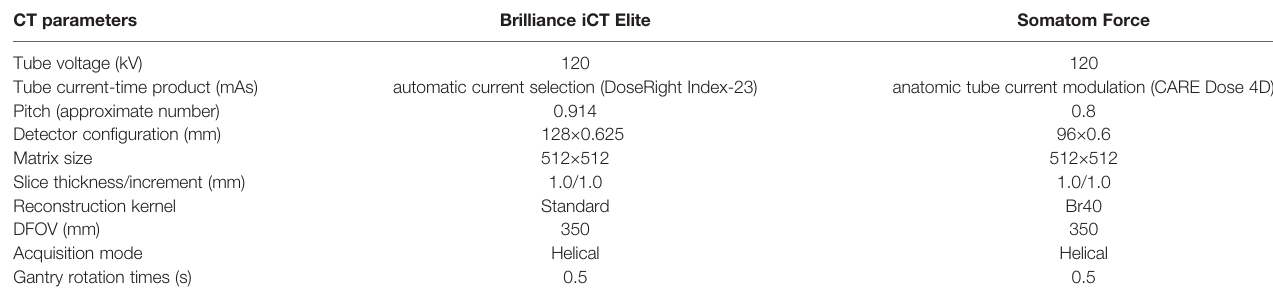
TABLE 1 | Summary of acquisition parameters of 2 CT